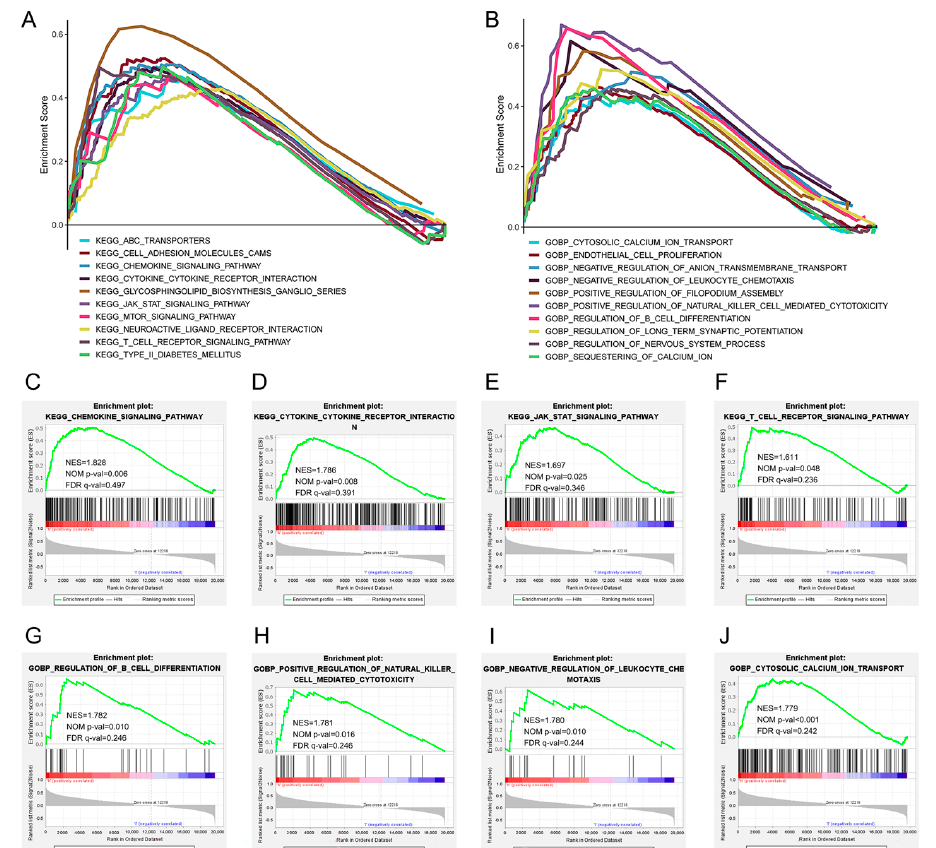
Figure 3. GSEA based on the EVL-high and EVL-low groups. ( A ) Top 10 upregulated GSEA-GO terms. ( B ) Top 10 upregulated GSEA-KEGG pathways. ( C – J ) Immune system-relevant signaling pathways and biological processes in GSEA results. EVL, Ena-VASP-like; GSEA, gene set enrichment analysis; NES, normalized enrichment score; NOM p -val, nominal p -value; FDR q-val, false discovery rate q-value; GO, gene ontology; KEGG, Kyoto encyclopedia of genes and